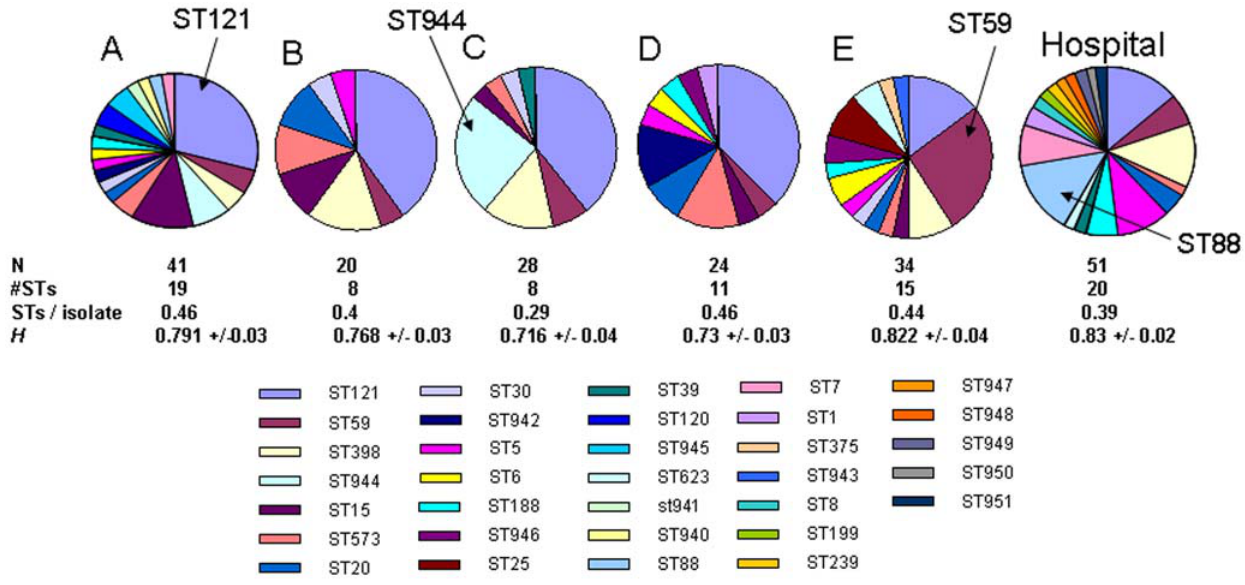
Figure 3. MLST genotypes of the carriage data broken down according to kindergarten. Two possible examples of local clonal spread are indicated by arrows: i) the high frequency of ST59 in kindergarten E, and ii) the high frequency of ST944 in kindergarten C. The diversity within each kindergarten was highly consistent, except for kindergarten C which shows a lower number of STs per isolate (not significant p , 0.05), and the lowest average heterozygosity per locus (H), calculated using Lian v3.5 as implemented on www.pubmlst.org. The breakdown for the disease sample is also shown for comparison, and reveals a high frequency of ST88.